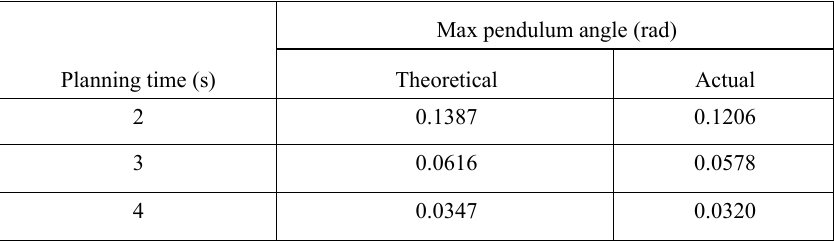
Table 3. Results in different planning